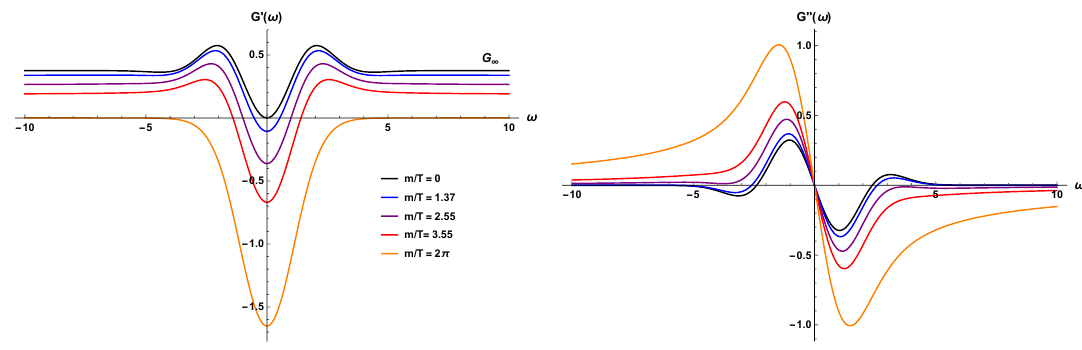
Figure 14 . The stress tensor Green function (4.26) in function of the frequency for various values of m=T . Left: the real part G 0 ( ! ). Right: the imaginary part G 00 ( ! ).